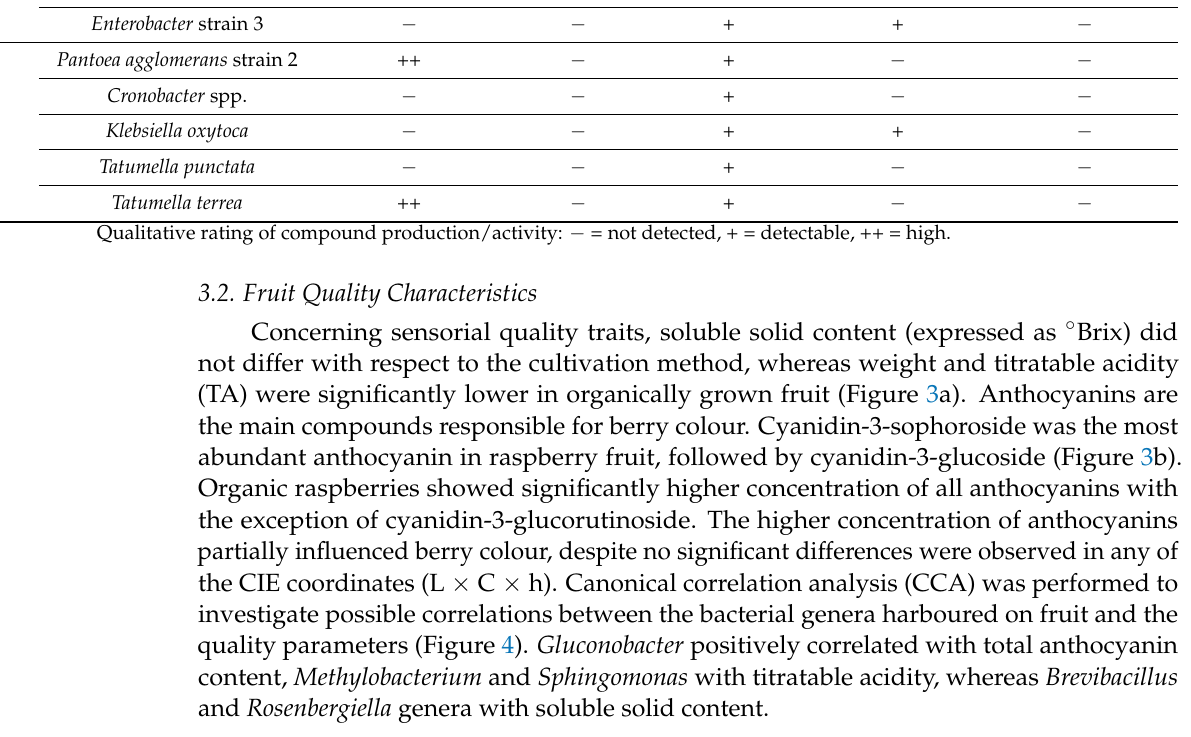
Figure 4. Canonical correlation analysis of bacterial genera discriminating organic from IPM grown fruit and quality parameters. Bacterial genera are coloured in brown, quality parameters in green. 3.3. Characterization of the Volatilome of Organic and Integrated Pest Management (IPM) Raspberry Fruits